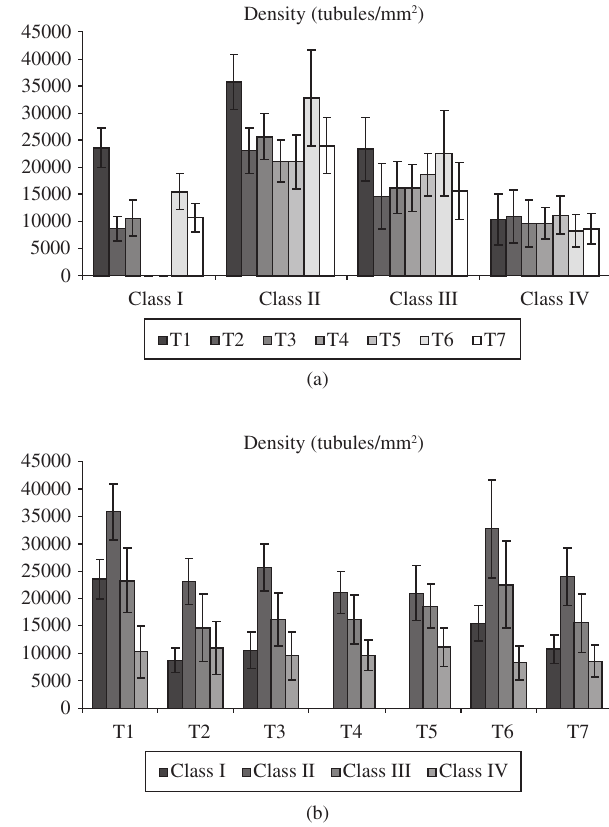
Figure 4. Average number of tubules a) per class of dentin and b) per